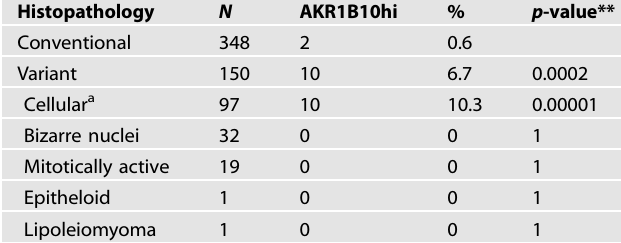
Fig. 1 Immunohistochemistry and histopathological evaluation reveal AKR1B10 expression and speci fi c morphological features in FH- pro fi cient leiomyomas. a 2SC and AKR1B10 antibodies can both act as biomarkers for FH-de fi ciency. Immunohistochemistry showed strong staining with both antibodies in FH-de fi cient tumors. It also revealed a subgroup of tumors positive only for AKR1B10 (AKR1B10hi). Histopathological evaluation of the AKR1B10hi tumors showed increased cellularity in most of them. Myometrium was negative for both AKR1B10 and 2SC. b Half of the AKR1B10hi tumors showed two or more features associated with FH-de fi ciency [37], including eosinophilic inclusions (top left), staghorn vasculature (top right), eosinophilic nucleoli and nuclear atypia (bottom left), and alveolar edema (bottom right). Example of eosinophilic nucleoli is marked with an arrow. c Half of the AKR1B10hi samples displayed perivascular hypercellularity, a feature not associated with leiomyomas previously. Magni fi cation 100× (left) and 200× (right). Table 1. Immunohistochemistry of 498 uterine leiomyomas reveal AKR1B10 expression in 12 FH-pro fi cient tumors